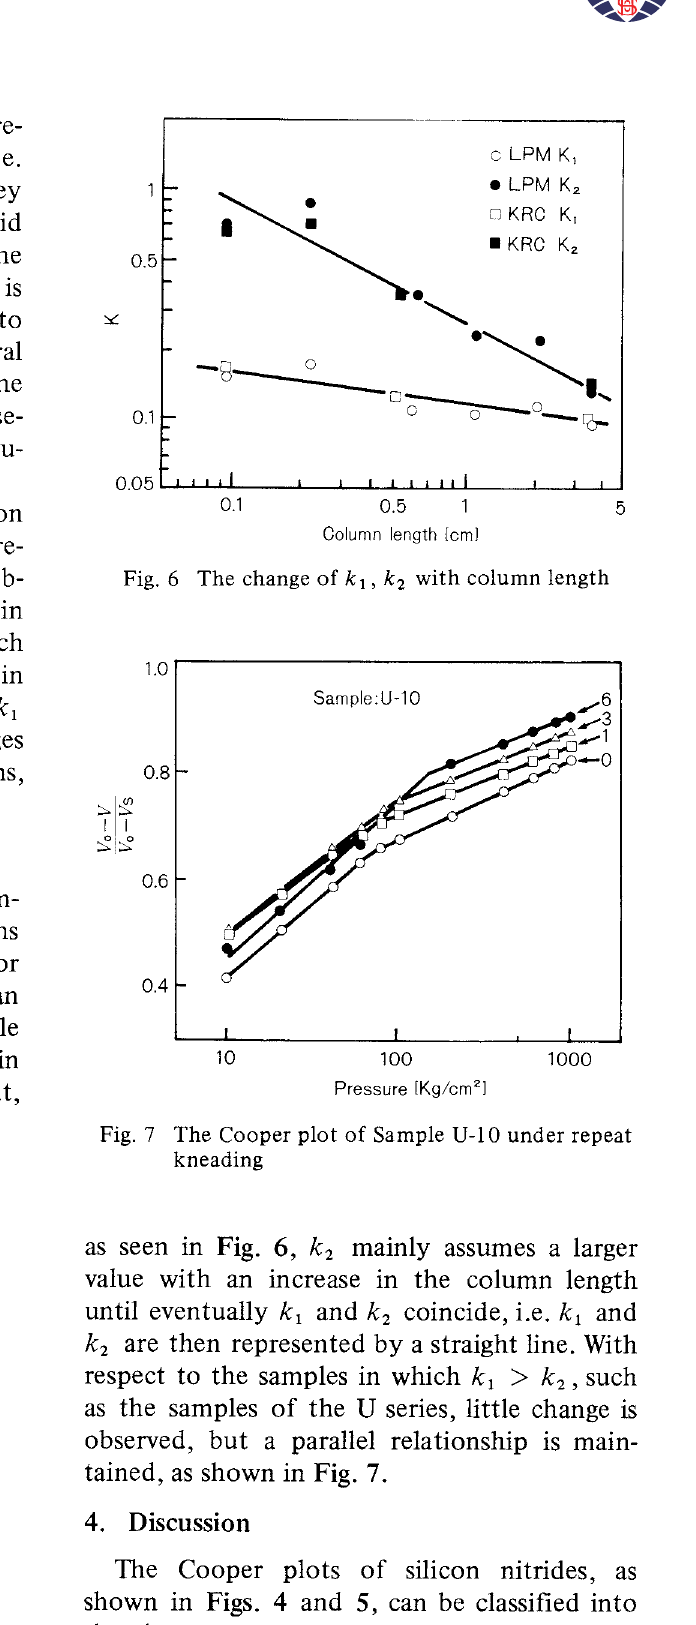
Fig. 5 The variation in the Cooper plot of Sample A with column length